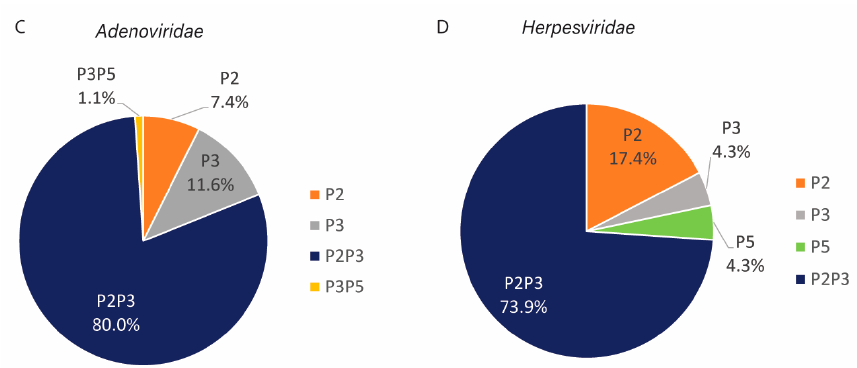
Figure 4. Bioinformatics of the sequence GRKTR and its variants present in proteins from DNA virus families that localize in the nucleus of infected cells. ( A , B ) The sequence GRKTR and its variants (listed in Table 2), the control peptide GLVTV, and the SV40 large T-antigen NLS were entered into the BLASTP algorithm. Only the numbers of hits for viral proteins that are known to function in the nucleus of infected cells are reported. The amino acids in red indicate substitutions from the WT NLS2. ( C , D ) Percentage of the sequence GRKTR and its variants present in the total viral proteins with these sequences from the Adenoviridae ( C ) and the Herpesviridae ( D ) families.